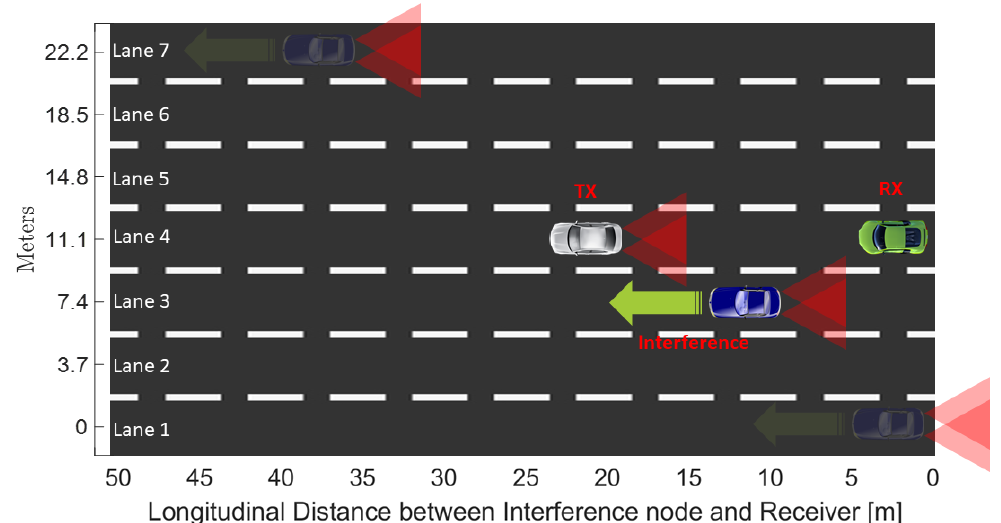
Figure 5. Target scenario: The intended transmitter (Tx: White vehicle) and receiver (Rx: Green vehicle) are in the middle lane at a fixed distance; the interfering vehicle (blue vehicle) is in various positions in the different